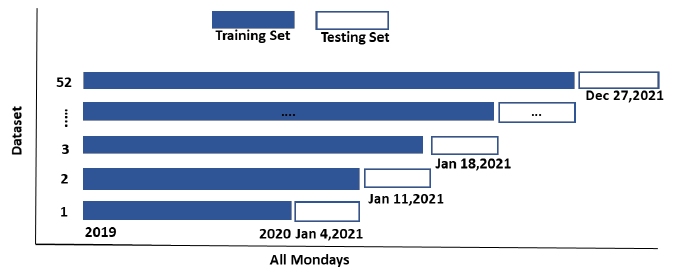
Figure 5. Sample dataset for walk-forward testing